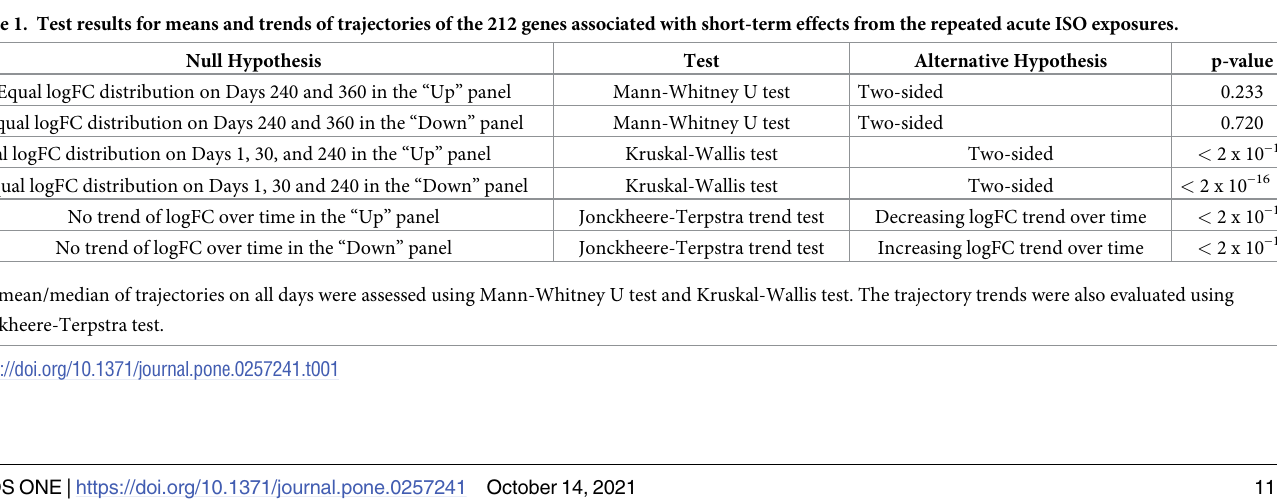
rhythm pathway at Day 1. However, significance of these genes faded away at/after Day 30.